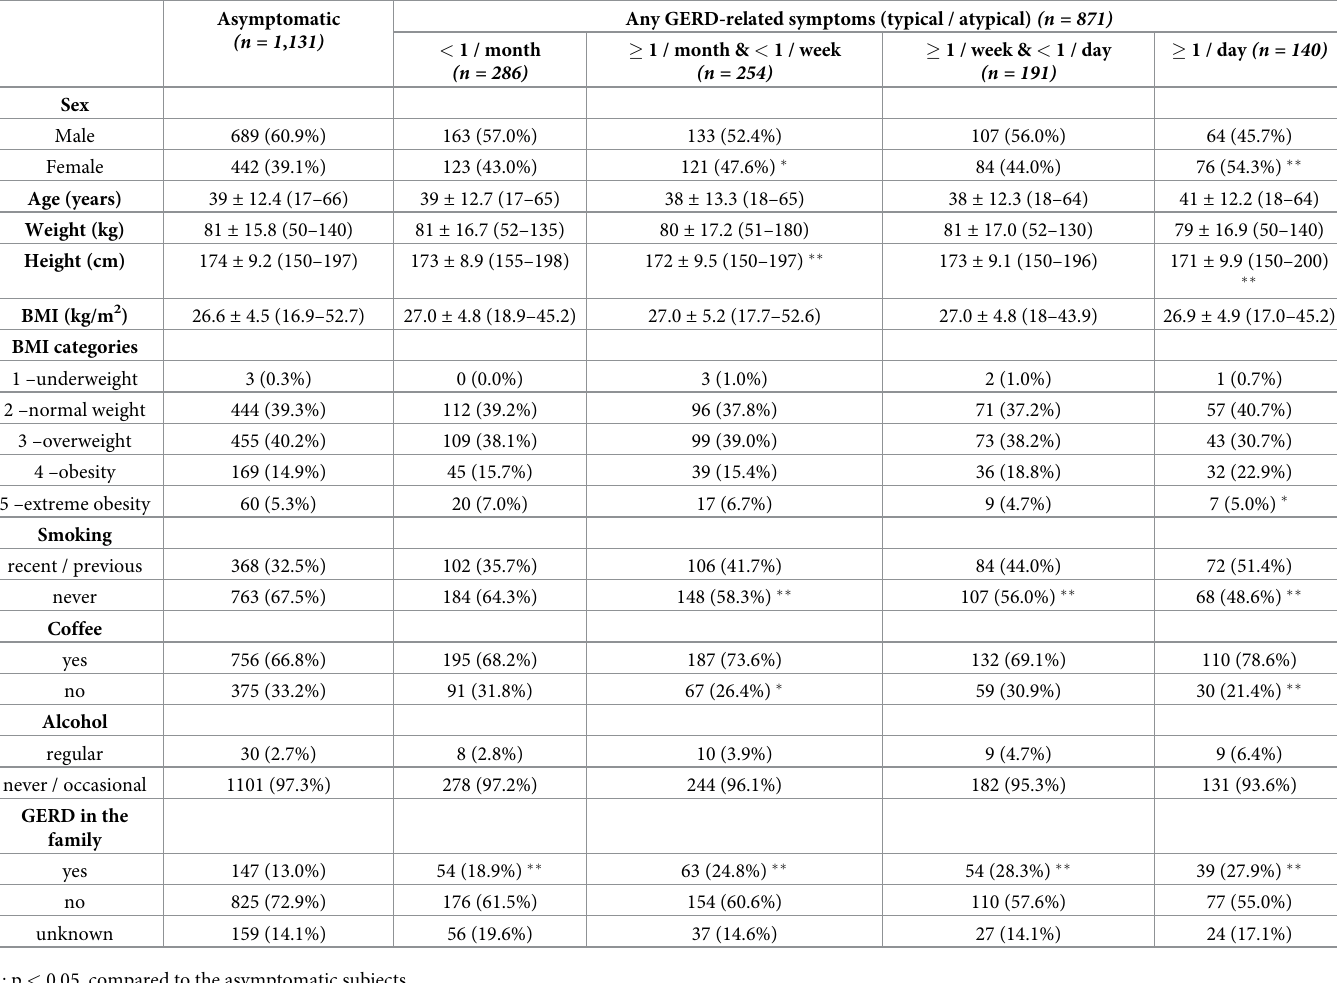
Table 3. Socioeconomical factors of blood donor volunteers with any GERD-related symptoms (typical and/or atypical). Age, weight, height and BMI are presented with mean ± SD and range.